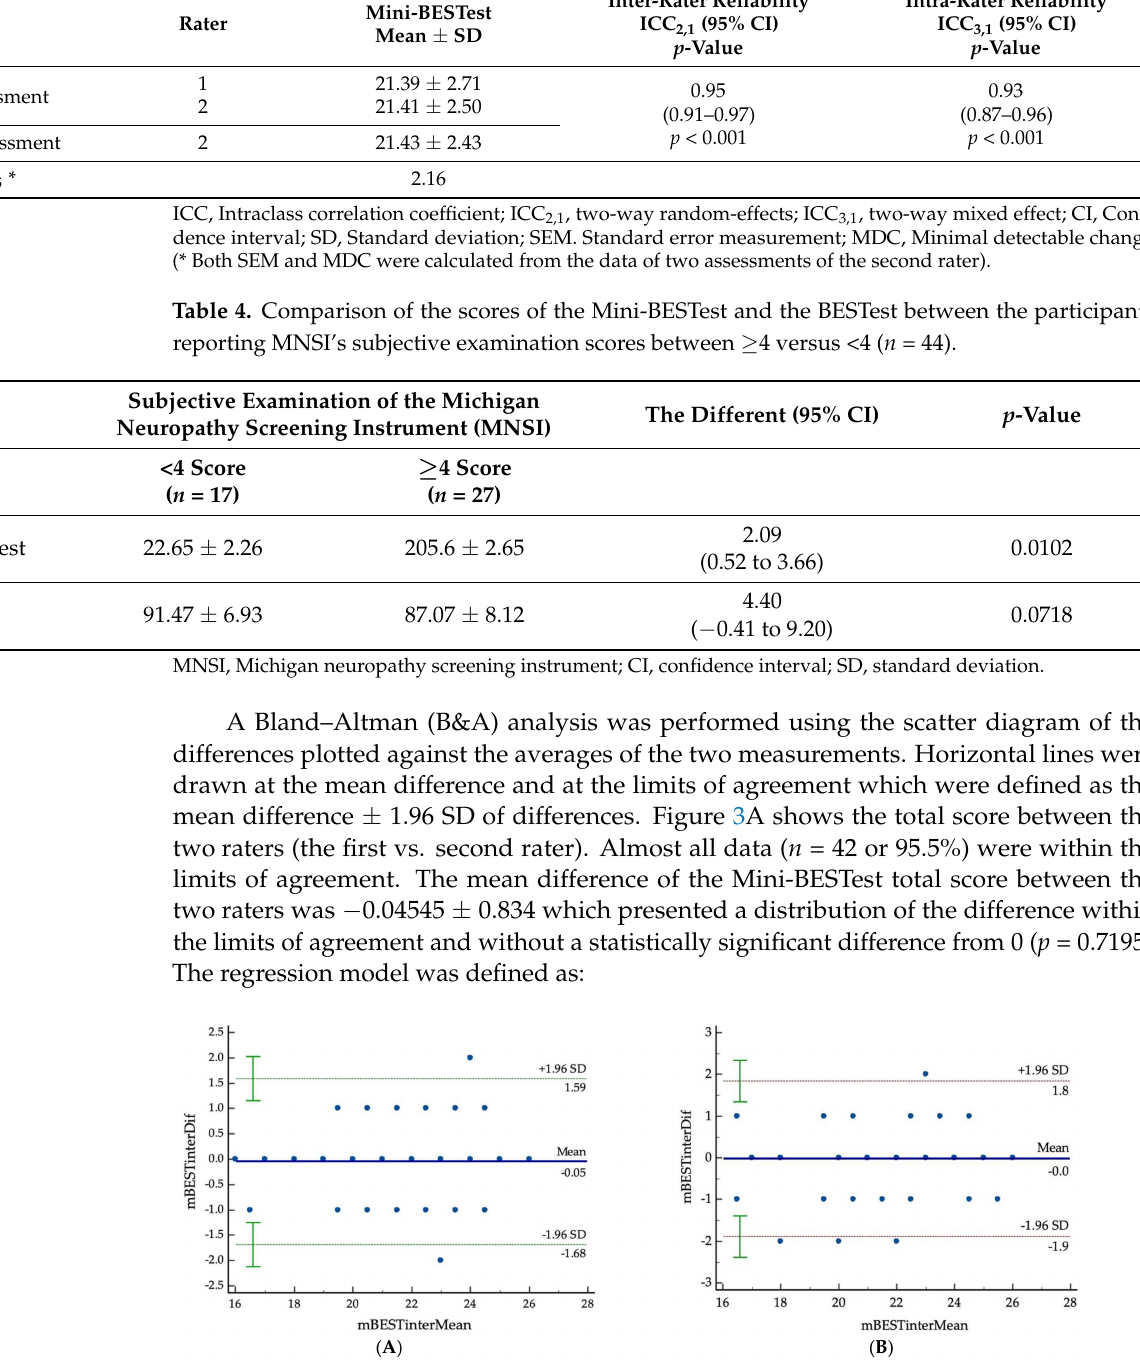
Figure 3. The Bland–Altman analysis of graphical representation of differences between raters (first vs. second rater) ( A ) and differences between two assessments from the second rater ( B ). The solid line in the middle represents the mean difference value of the sample ( n = 44) due to the same value (26 dots are present in the graph). The dashed lines represent the upper and lower limits of agreement between the two data sets (mean ± 1.96 SD). mBESTinterDif = The difference of the Mini-BESTest total score; mBESTinterMean = The mean of the Mini-BESTest total